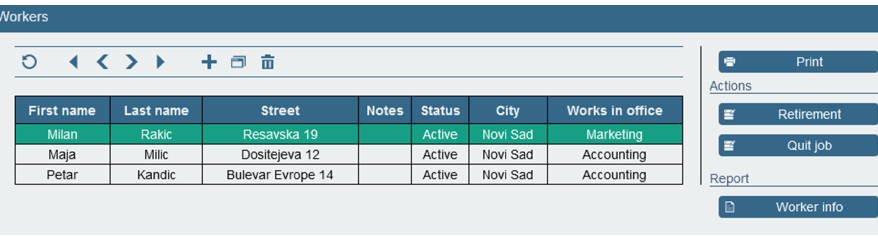
Figure 13. A web page for managing workers data in a view